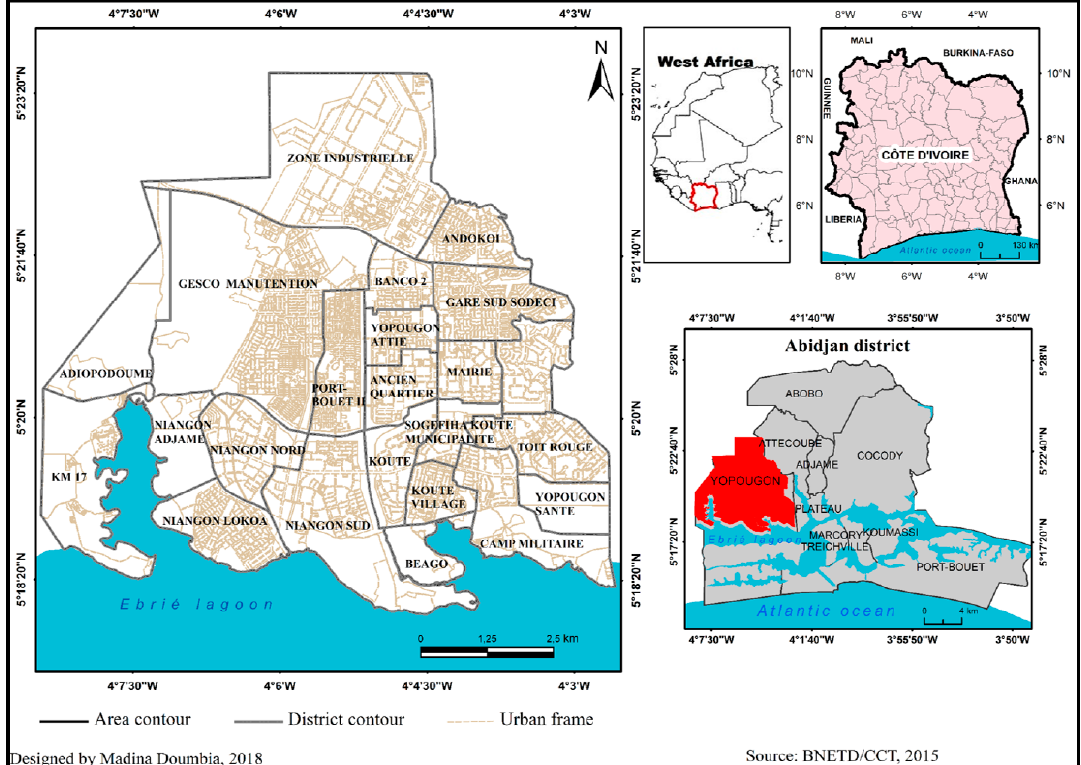
Figure 1. Map of the study area (Yopougon in red) showing the 23 administrative districts or sub-areas. Yopougon is one of the 10 communes of the city of Abidjan. Yopougon, a coastal municipality, is the largest and most extensive of the 10 communes.